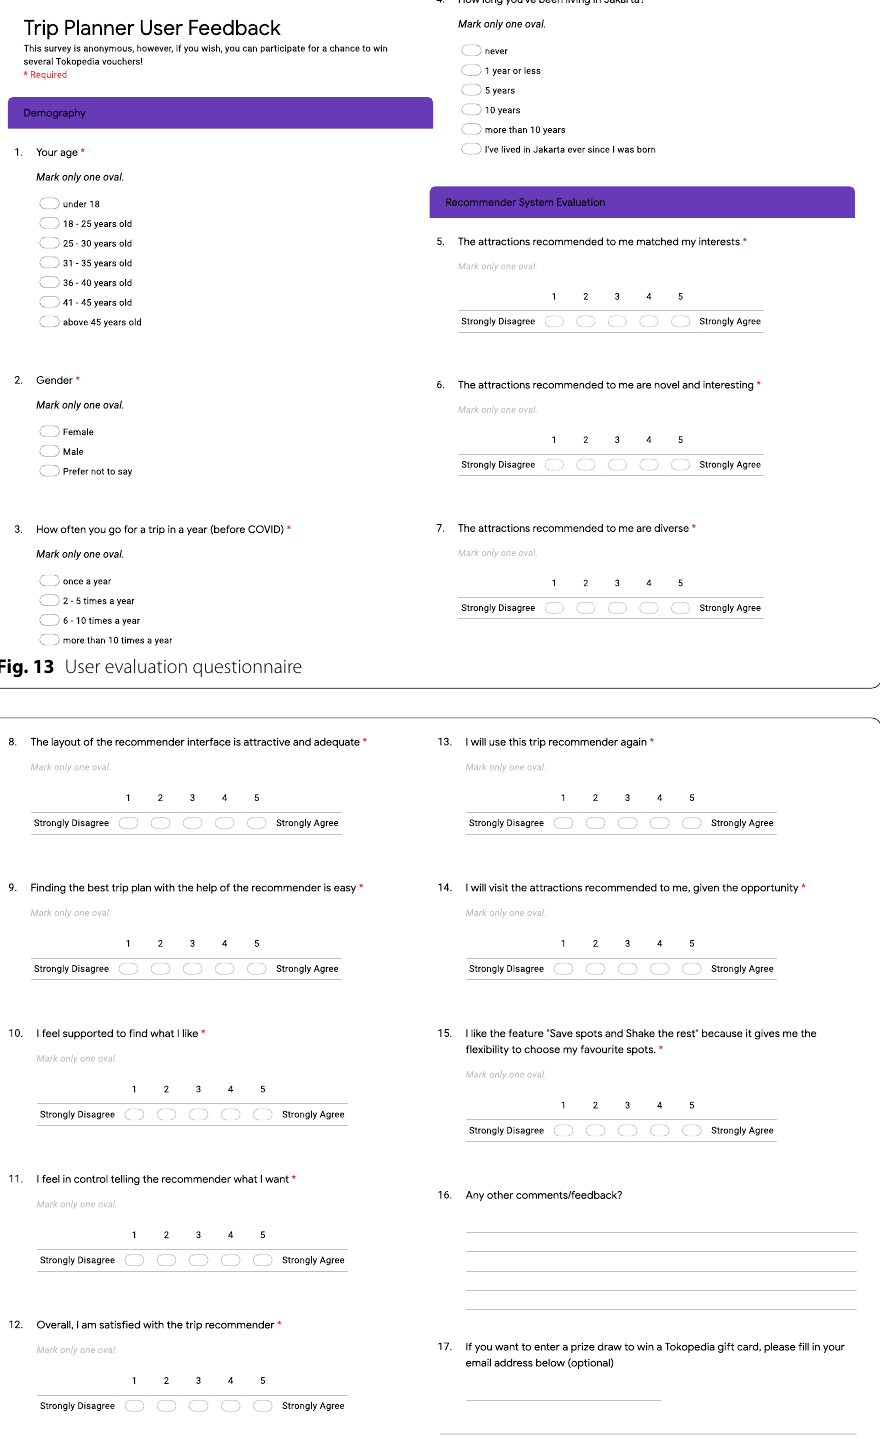
Fig. 14 User evaluation questionnaire